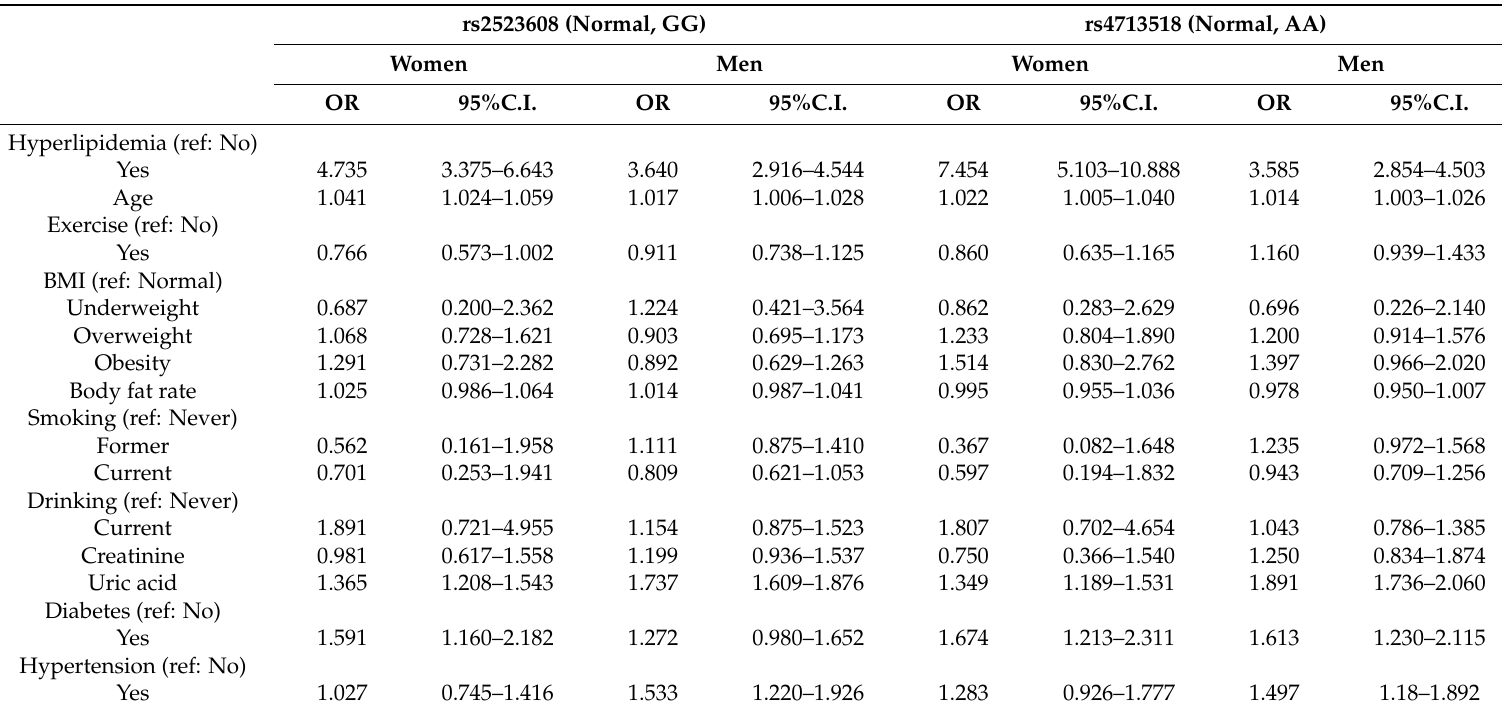
Table 4. Association of gout with hyperlipidemia in Taiwanese men and women based on rs2523608 GG and rs4713518 AA